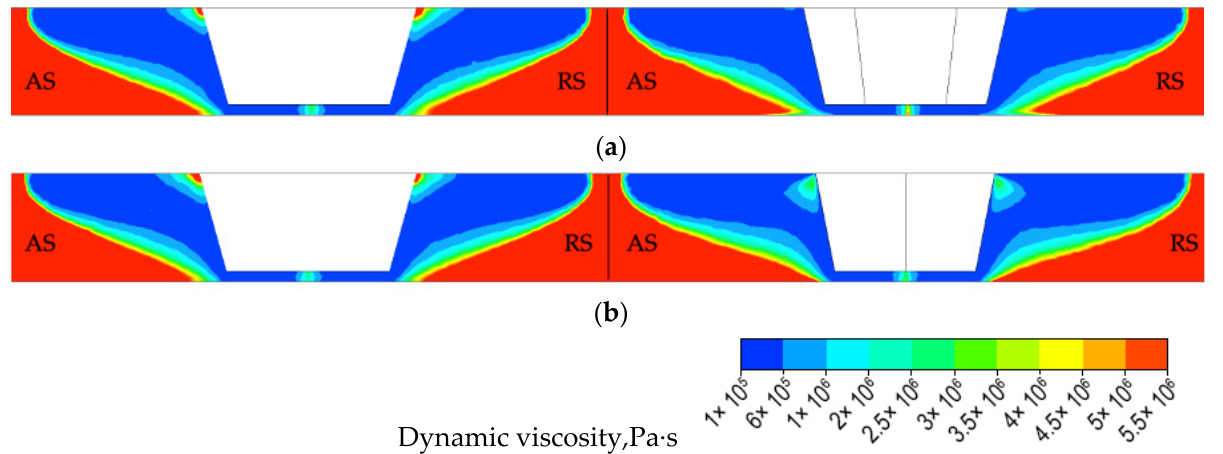
Figure 9. Temperature distribution for both FSW − C ( left ) and FSW − H ( right ), transverse section (according to the cross − section line in Figure 8).